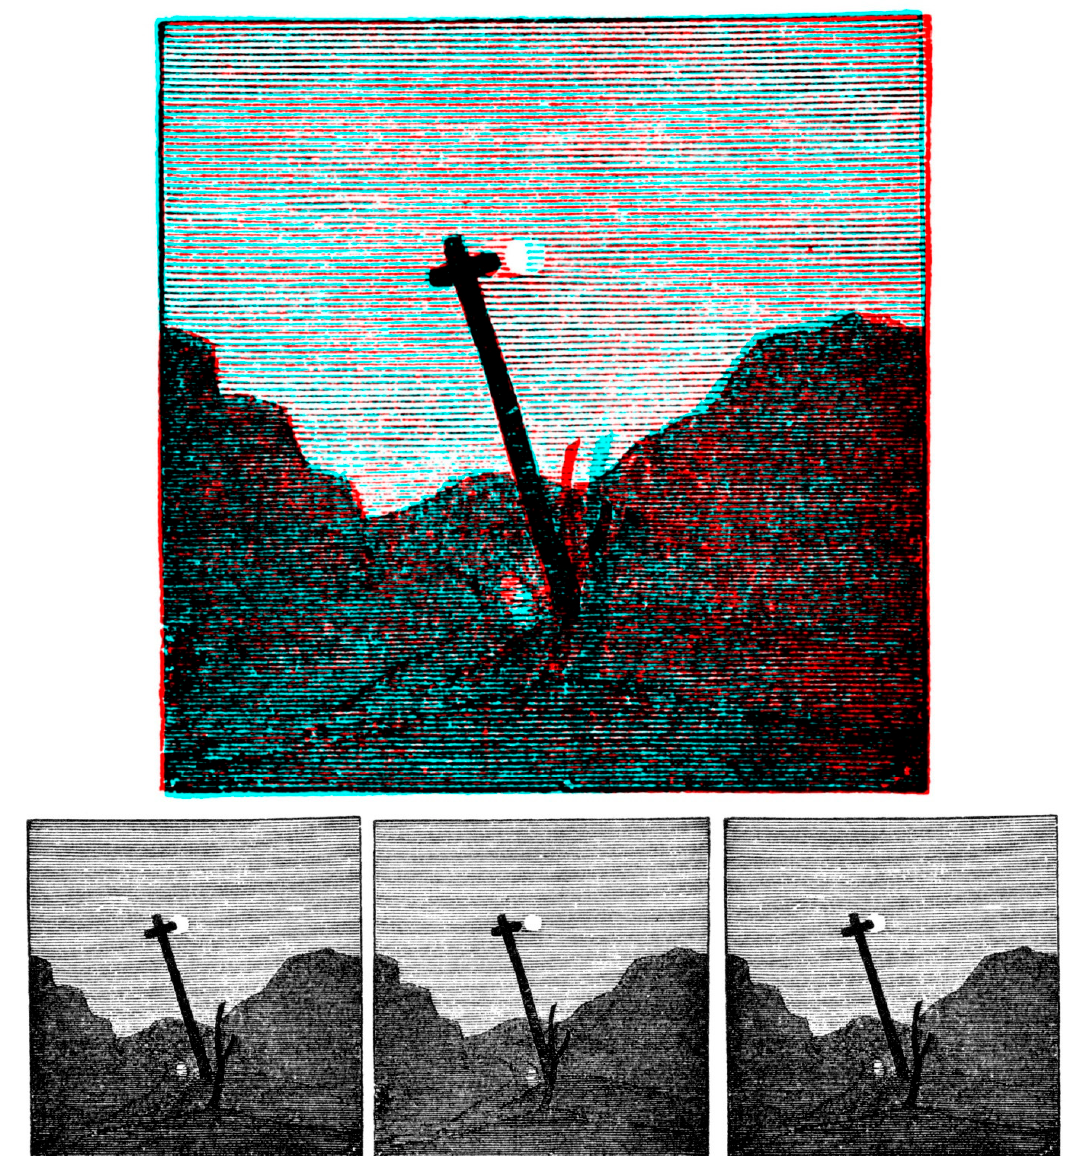
Figure 5. Elliot’s stereoscopic landscape. The lower left and centre images are from Brewster [35].